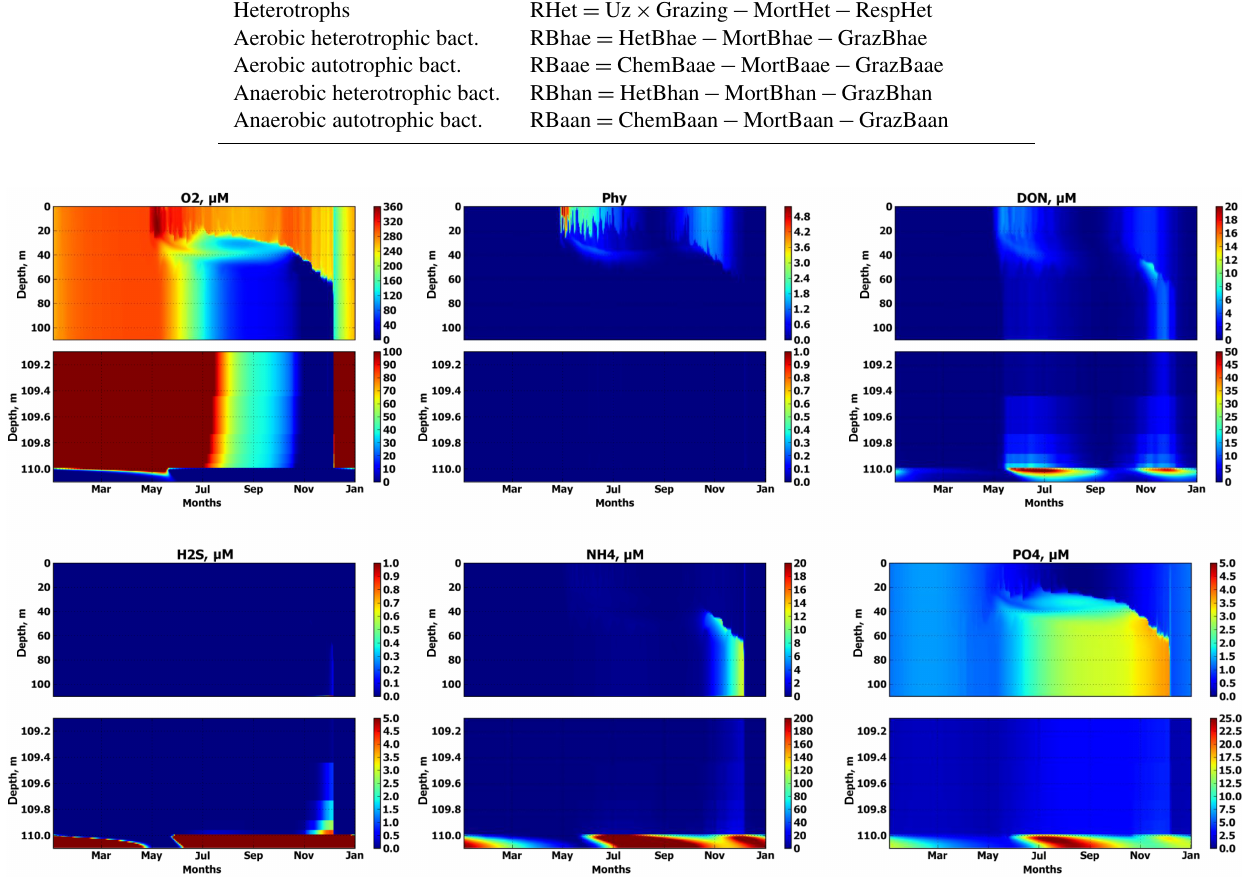
Figure 2. Simulated seasonal variability of the selected modeled chemical parameters (µM), in the water column (top panels) and in the benthic boundary layer and sediments (bottom